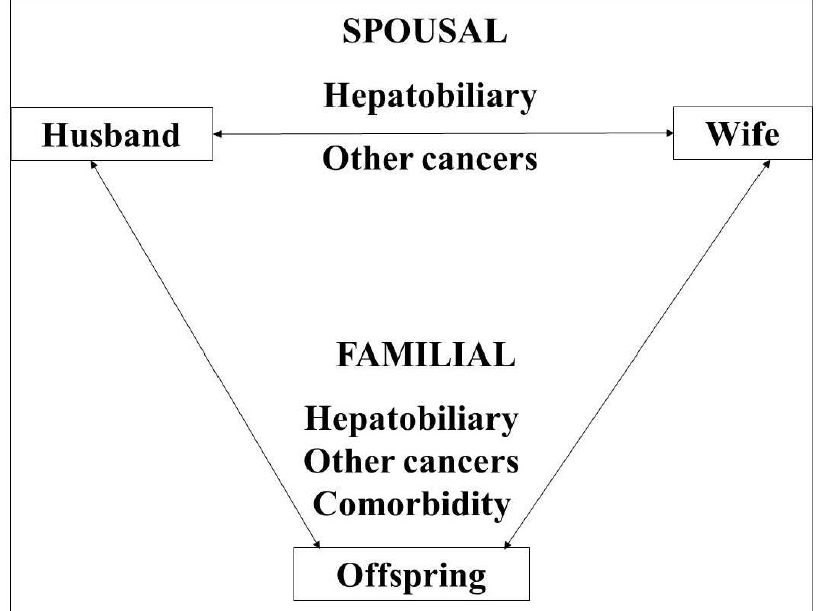
Figure 1. The scheme for the current analysis highlighting the study subjects (parent–offspring and spouses), the types of analysis (familial and spousal) and the diseases (hepatobiliary and other cancers, and comorbidities of hepatobiliary cancer)